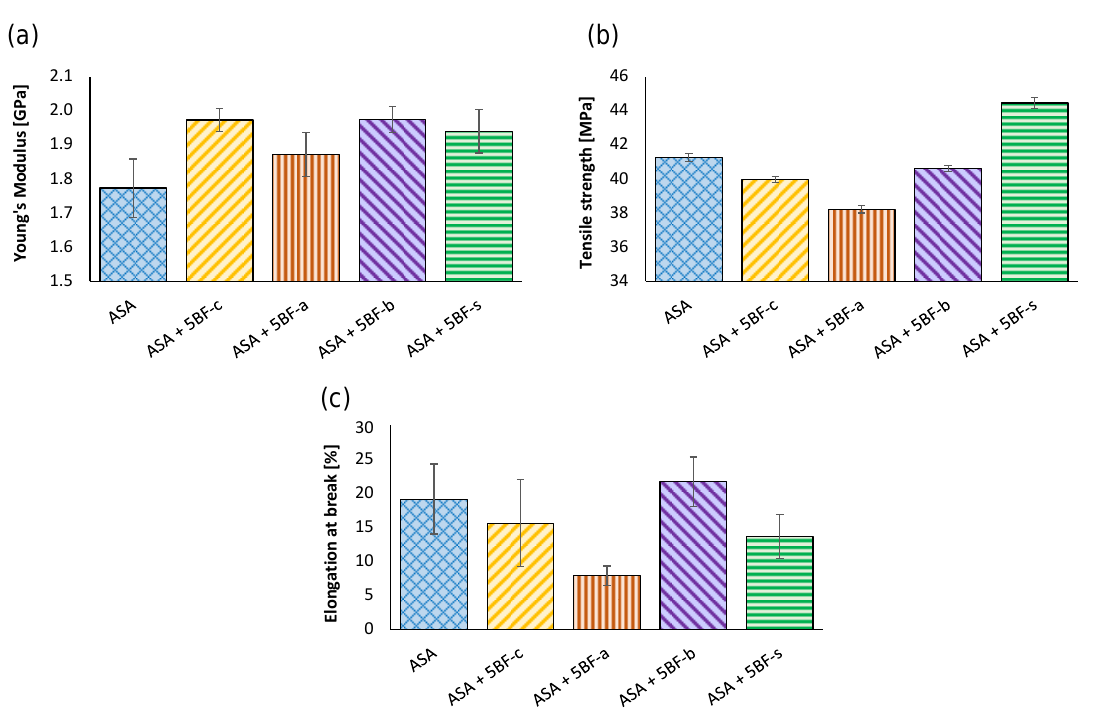
1 cm Figure 4. IM samples after the tensile test of ASA and 5 wt% BF composites studied in this work. To gain further insight into the effect of the different treatments applied to the BFs, SEM analysis was done to the different BFs, showed in Figure 5. BF-c and BF-b showed a smooth surface, which seems to indicate that these treatments were not aggressive enough to damage the structure of the BFs. The BF-b treatment did not lead to any sig- nificant modification in the BFs, since the mechanical parameters dissected for BF-b are not significantly different to those obtained for BF-c. In the case of BF-a, it shows small cracks in the surface even before compounding the composite. Consequently, these cracks are likely to act as nucleation points of crazes inside the composite during the tension test [37]. This explains the weaker behavior of the BF-a composites observed in Figures 2 and 3, compared to all other composites. SEM image of BF-s show enhanced roughness in the surface and shows some regions where traces of the silane coupling agent can be found. This increases the surface roughness of the fiber, while it also modi-